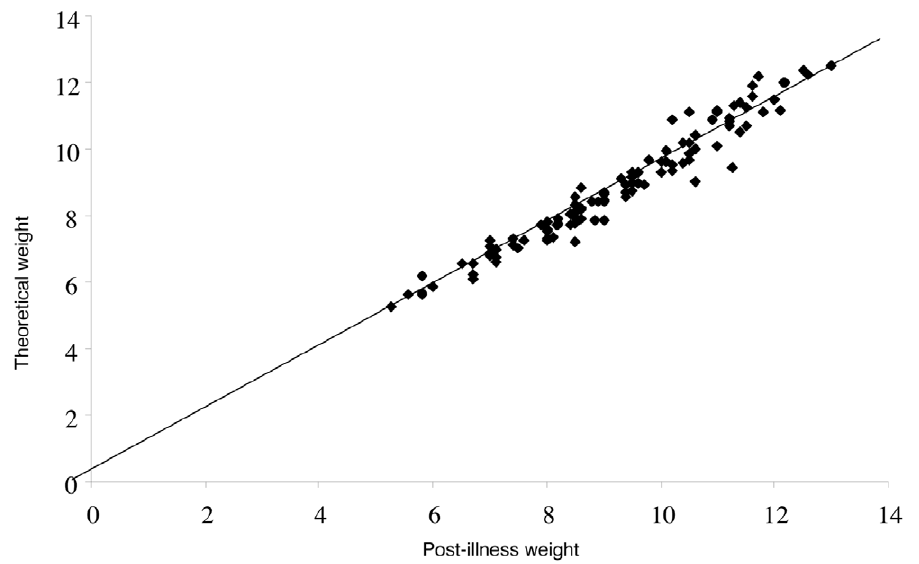
Figure 2. Correlation between theoreti cal and post-illness weight, assessed by Pearson Correlation (n =111). Postillness weight =0.978 x Theoretical weight (p , 10 2 6 ).